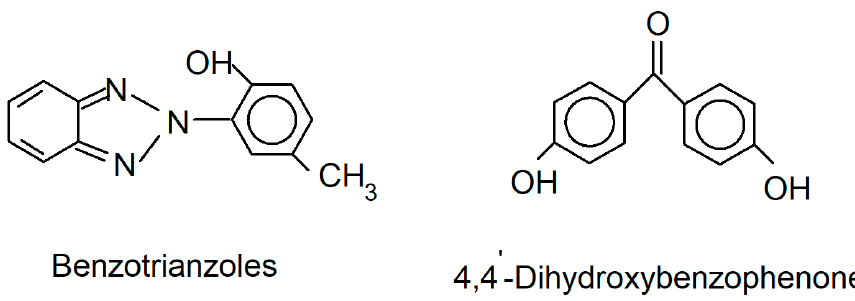
Figure 2. Example of UV absorbers.